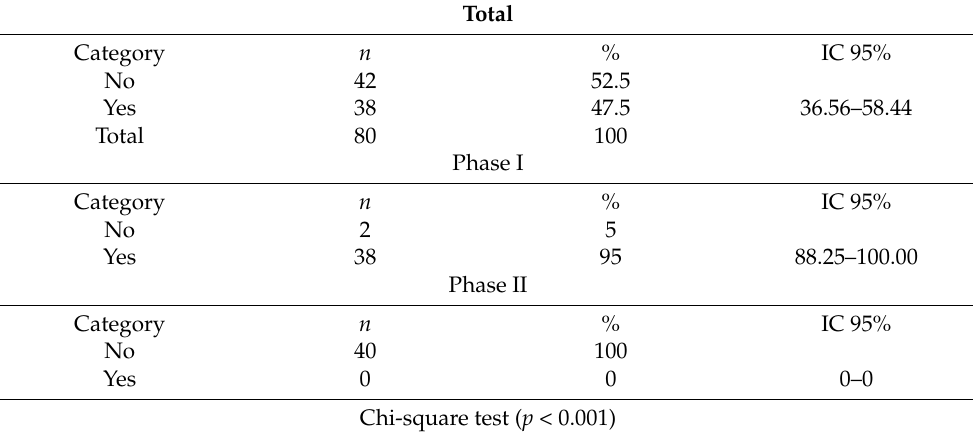
Table 5. Refusal to radiographic examination between phase I and phase